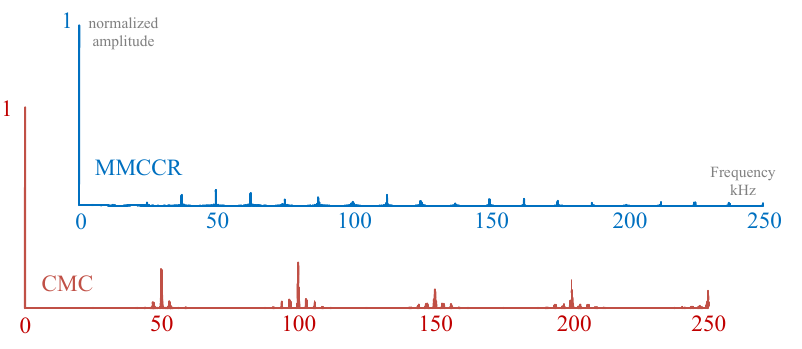
Figure 24. The input current spectrums for both converters. The proposed MMCCR topology contains four matrix converters and three-phase shifter circuits. As mentioned in an introduction section, the power is equally divided with among these matrix converters. Example PS currents i PS1 , i PS2 , and i PS3 are shown in Figure